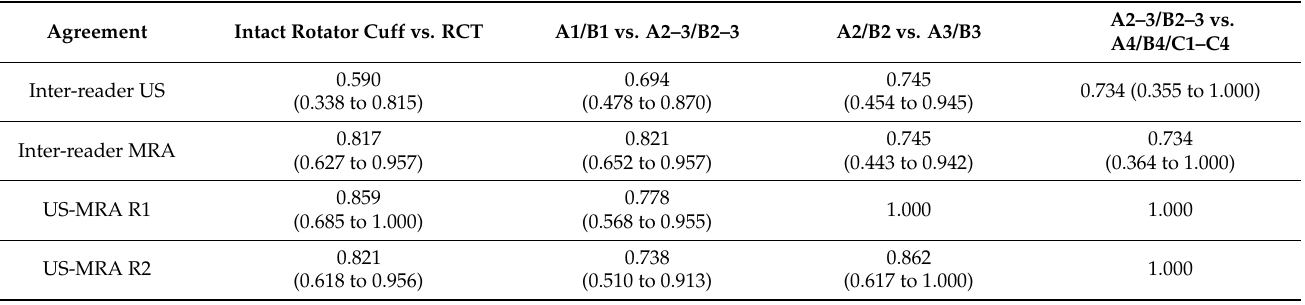
Table 3. Inter-reader intra-modality and intra-reader inter-modality concordance using Cohen’s kappa values (CI 95%). Paired t test was significant for all different classes with p <0.001.